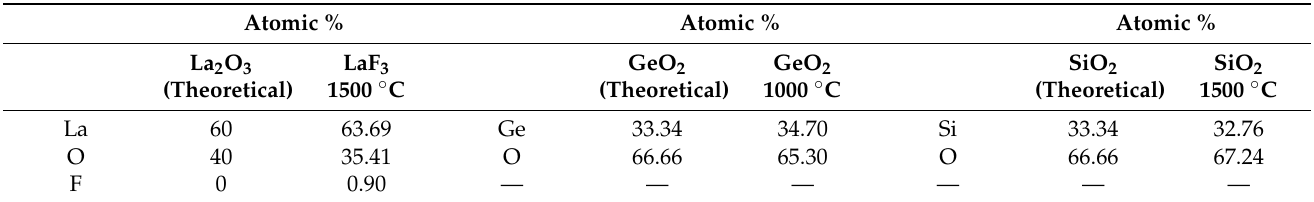
Table 4. Theoretical and average atomic percentages obtained by EDX of the different elements constituting the three studied compounds after thermal treatment.